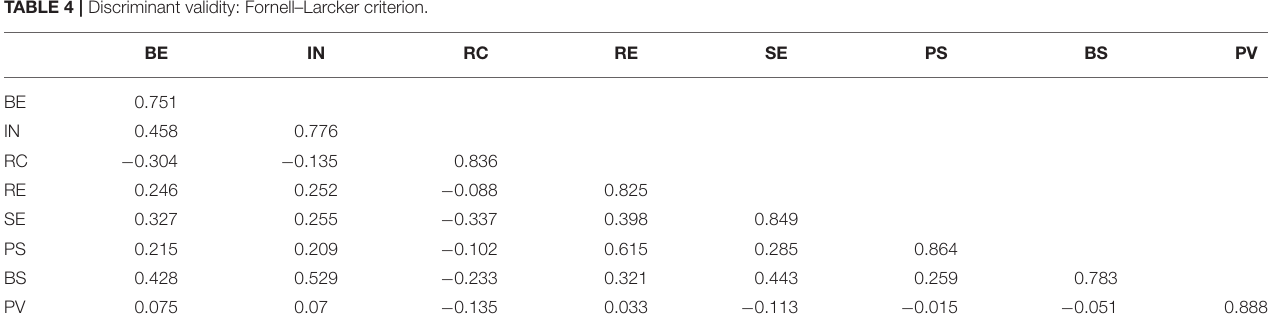
TABLE 4 | Discriminant validity: Fornell–Larcker criterion.